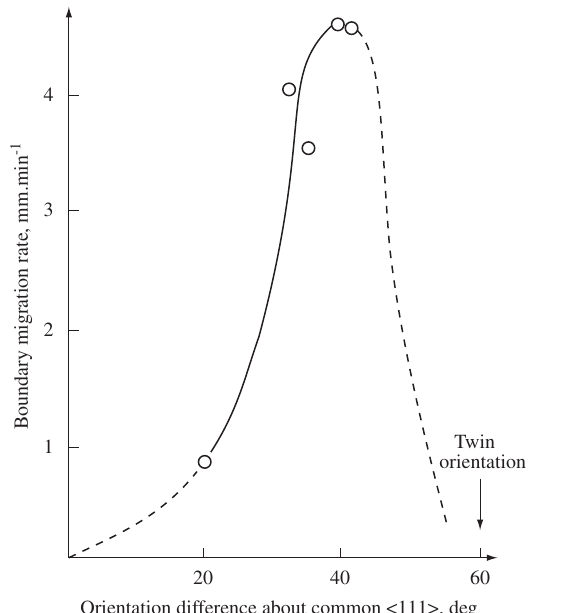
Figure 9. Changes in mobility as a function of the misorientation angle θ (schematic). Practically there are no data available in the literature for the range of 5° < θ <